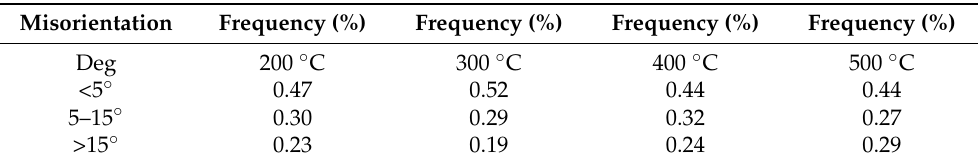
Figure 8. Misorientation distribution of the Cu-Sn-P alloy at different temperatures: ( a ) 200 °C, ( b ) 300 °C, ( c ) 400 °C, and ( d ) 500 °C. Table 2. Frequency of grains with various misorientations in the Cu-Sn-P alloy.